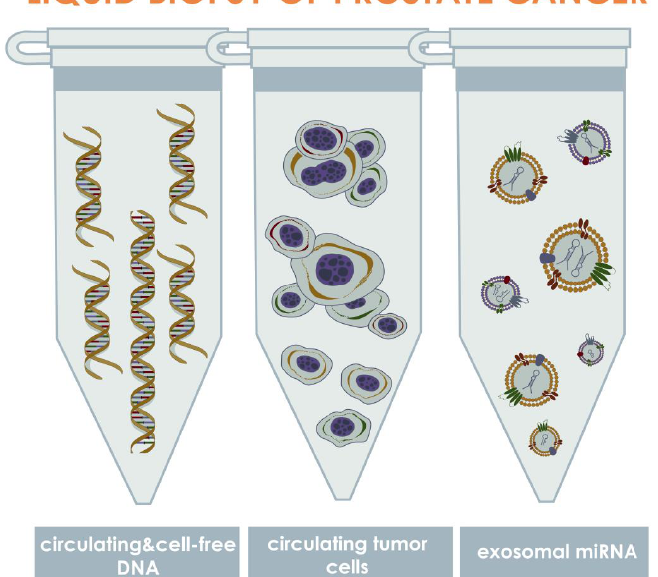
Figure 1. Approaches for liquid biopsy of PCa via isolation and identification of circulating bi- omarkers. The approaches may be stratified into three primary groups depending on the type of isolated biomarkers, which are: circulating tumor DNA (ctDNA), circulating tumor cells, and exo- somal miRNAs. The ctDNAs are the fragments of DNA, released into the bloodstream as a result of tumor cell death or exocytosis; tumor cells are the cells that shed into the biological fluids from primary or secondary tumor sites; exosomes are the microvesicles containing diverse biologically active agents that have been considered biomarkers, including miRNAs presenting in EVs, which release from tumor cells into the biological fluids as a result of cellular metabolism. In PCa, these biomarkers can be mainly found into three biological fluids such as blood, urine, and semen. CTCs are the cells that are shed into diverse biological fluids of a human body from primary or secondary tumor sites, and therefore may be detected in cancer patients while undetectable in healthy individuals [18]. The CTCs are vastly heterogeneous, first of all in terms of antigen profile and gene mutations [19]. Cell-free ctDNA are the fragments of DNA, which release into the body fluids due to lysis or apoptosis of tumor cells, or exo- cytosis [20,21]. Exosomes are the extracellular vesicles which are formed as a result of cell membrane blebbing and are released from tumor cells during their functioning. These vesicles are bearing various agents, including miRNAs, which may be recognized as tu- mor biomarkers [22]. The listed biomarkers are identified in such biological fluids of PCa patients as blood, urine, and semen [23]. The aim of this systematic review was to compile the existing data within the research field of liquid biopsy as the technique for early diag- nosis and prognosis of PCa, to analyze the collected data, and to provide potential direc- tions for investigations which would allow to implement the technique in clinic.